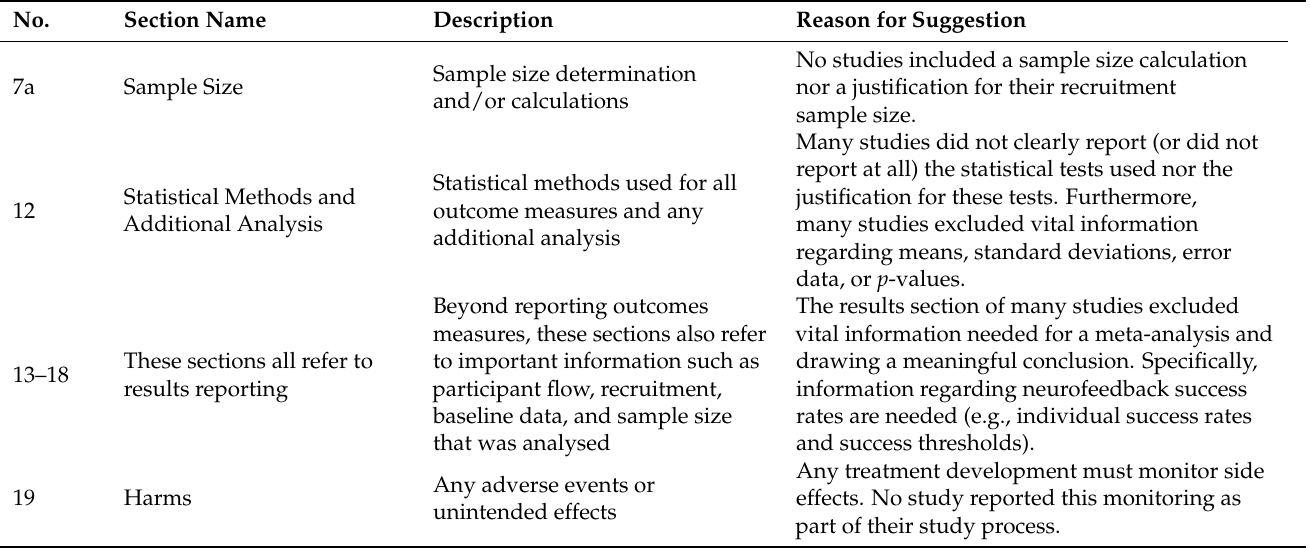
Table 6. Specific sections that should be followed by studies developing neurofeedback for PD motor